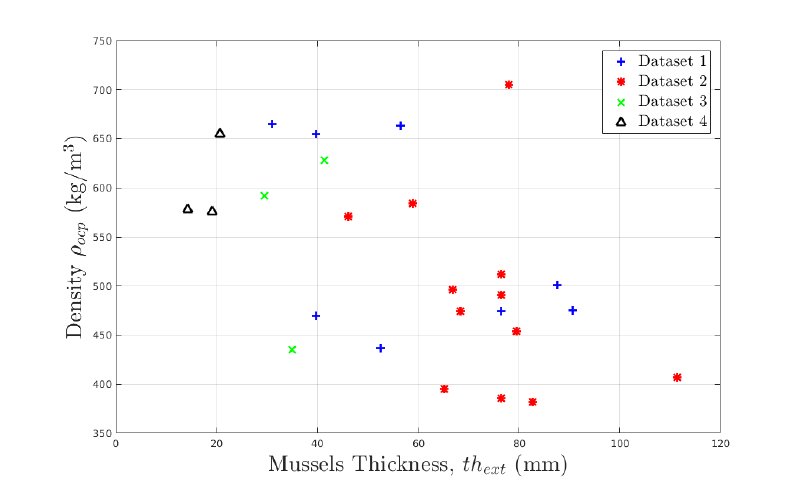
Figure 14. Density ρ ocp (kg · m − 3 ) of mussels colonisation depending on its